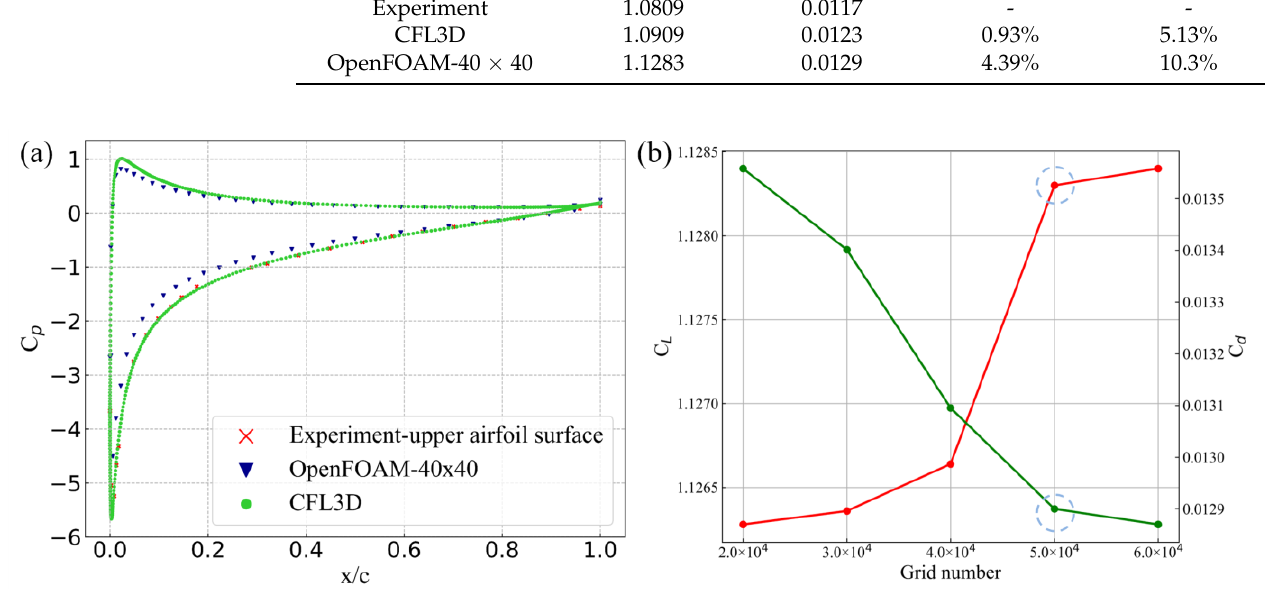
Figure 6. ( a ) Surface pressure coefficient from different data sources vs. normalized chord length; ( b ) grid independence study. ( b ) grid independence